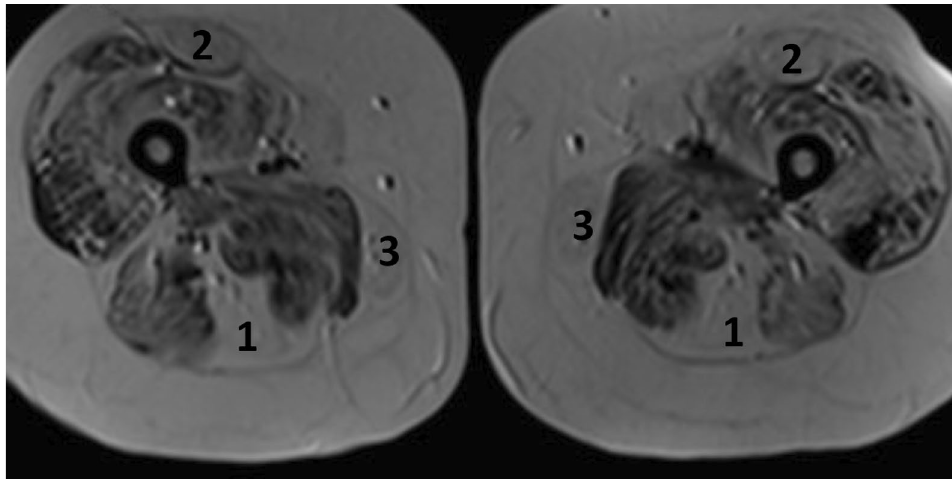
Fig. 1 Axial T2-weighted muscle MRI of the upper part of the lower limbs showing fat infiltration and fibrosis affecting all compartments with the most pronounced involvement of the semitendinosus and semimembranosus (1), rectus femoris (2) and gracilis (3)